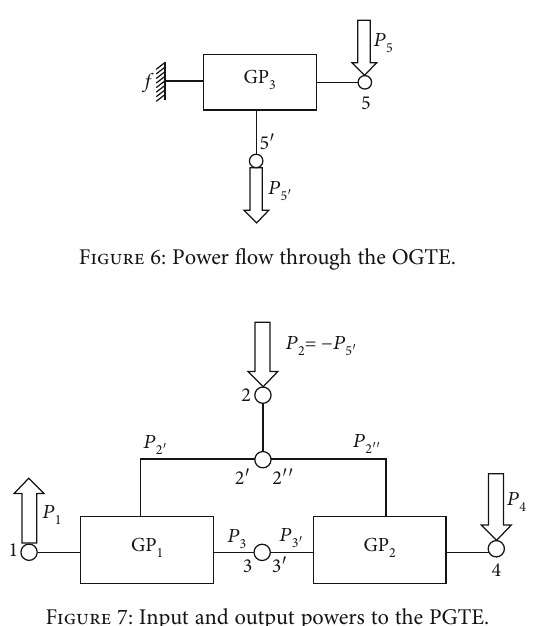
Figure 9: Power fl ow when ω